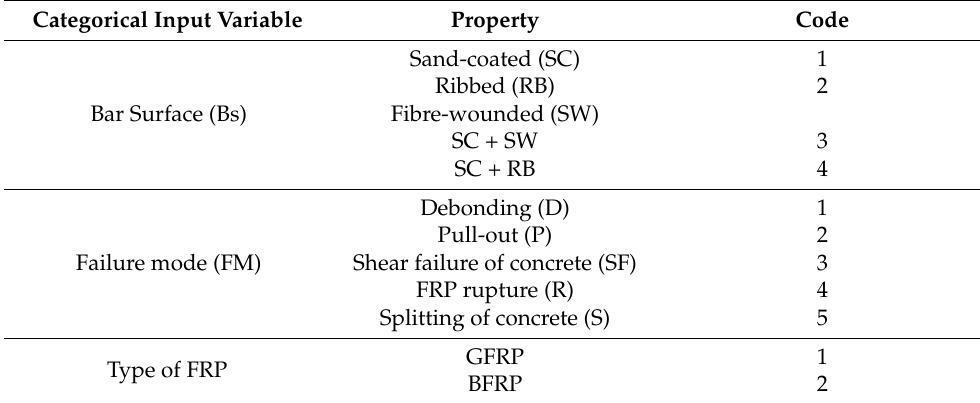
Table 2. Code applied for modelling categorical variables in GEP